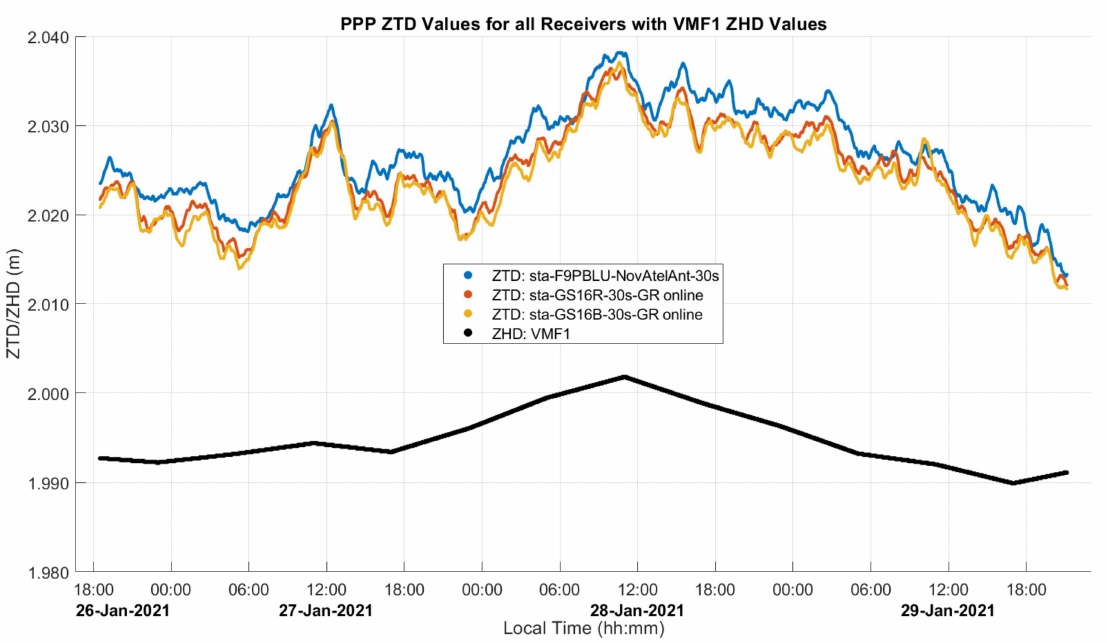
Figure 8. Static dataset A ZTD profiles produced by the three receivers used and VMF1 as initial condition in the software. The three profiles agree within a few millimetres. The ZHD estimated using only VMF1 with the PPP-derived coordinates is also shown; the 6 h update rate of VMF1 is evident. The difference between ZHD and ZTD is ZWD as shown in Figure 9. Local time is UTC −